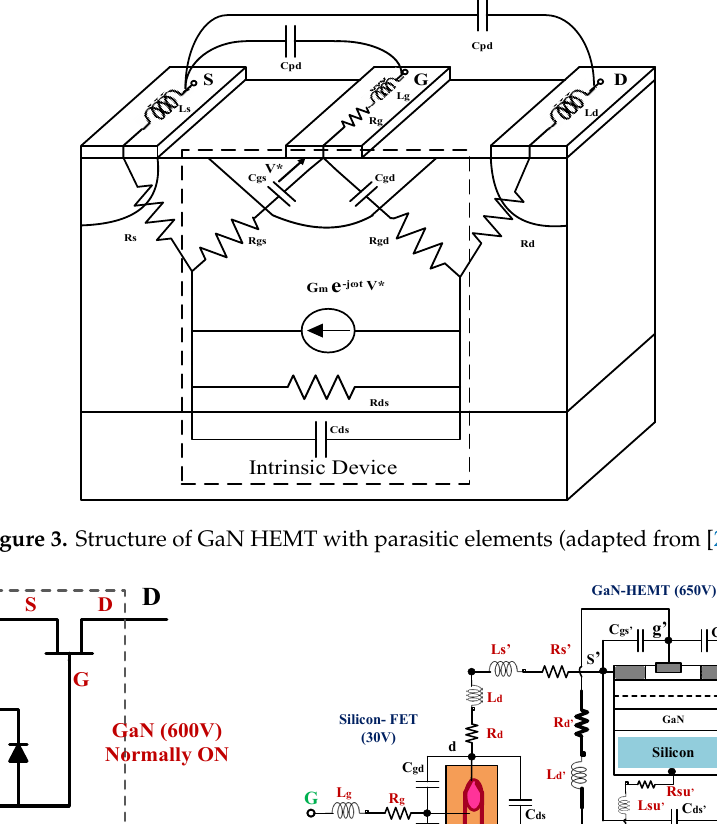
Figure 3. Structure of GaN HEMT with parasitic elements (adapted from [28]).